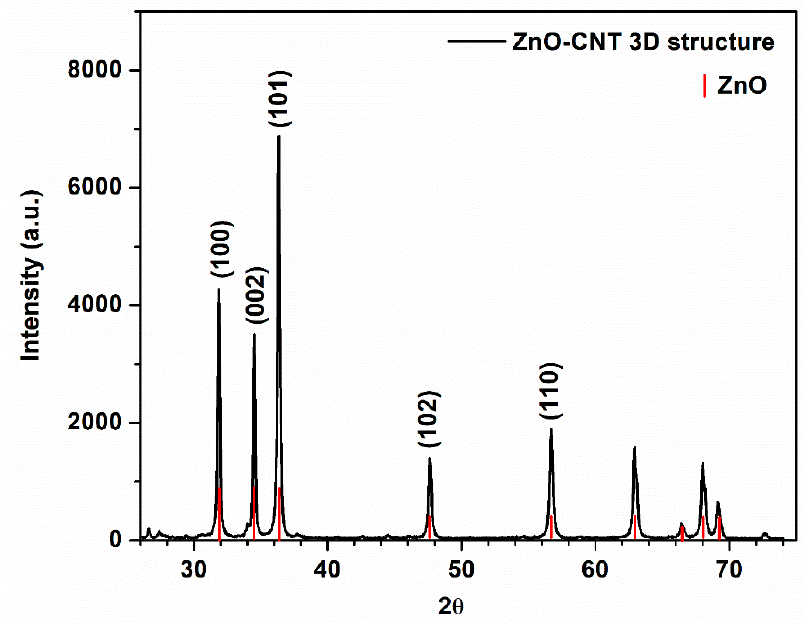
Figure 4. XRD pattern of ZnO-CNT-based 3D support structure before impregnation.